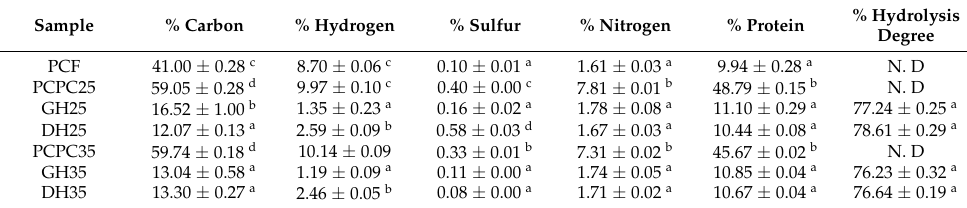
Table 1. Elemental composition, quantification of protein of PCPCs and hydrolysates and hydrolysis degree of hydrolysates (GH25, DH25, GH35 and